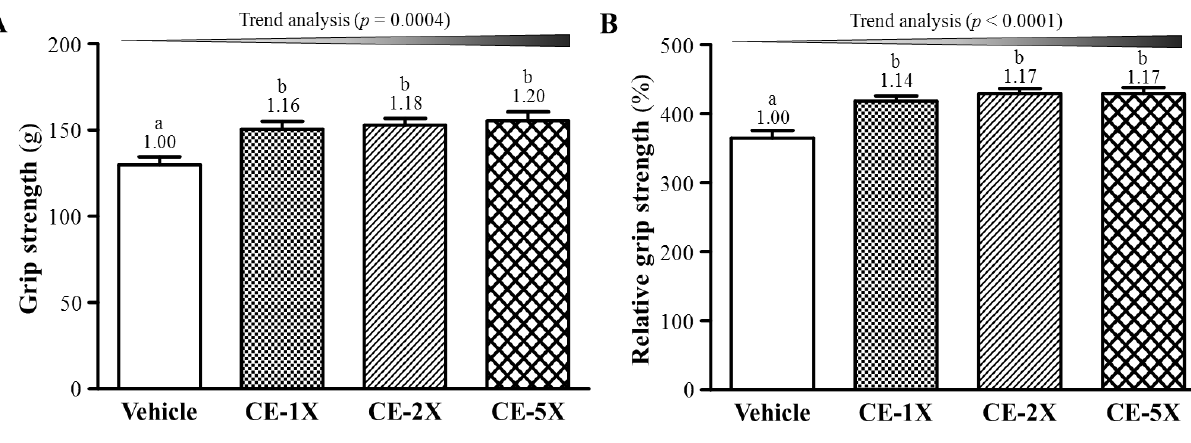
Figure 1. Effect of 4-week chicken essence (CE) supplementation on absolute forelimb grip strength ( A ) and forelimb grip strength (%) relative to body weight ( B ). Data are mean ± SEM for n = 10 mice per group. Bars with different letters (a, b) are significantly different at p < 0.05. Numbers above the bars are the fold increase from vehicle. Vehicle